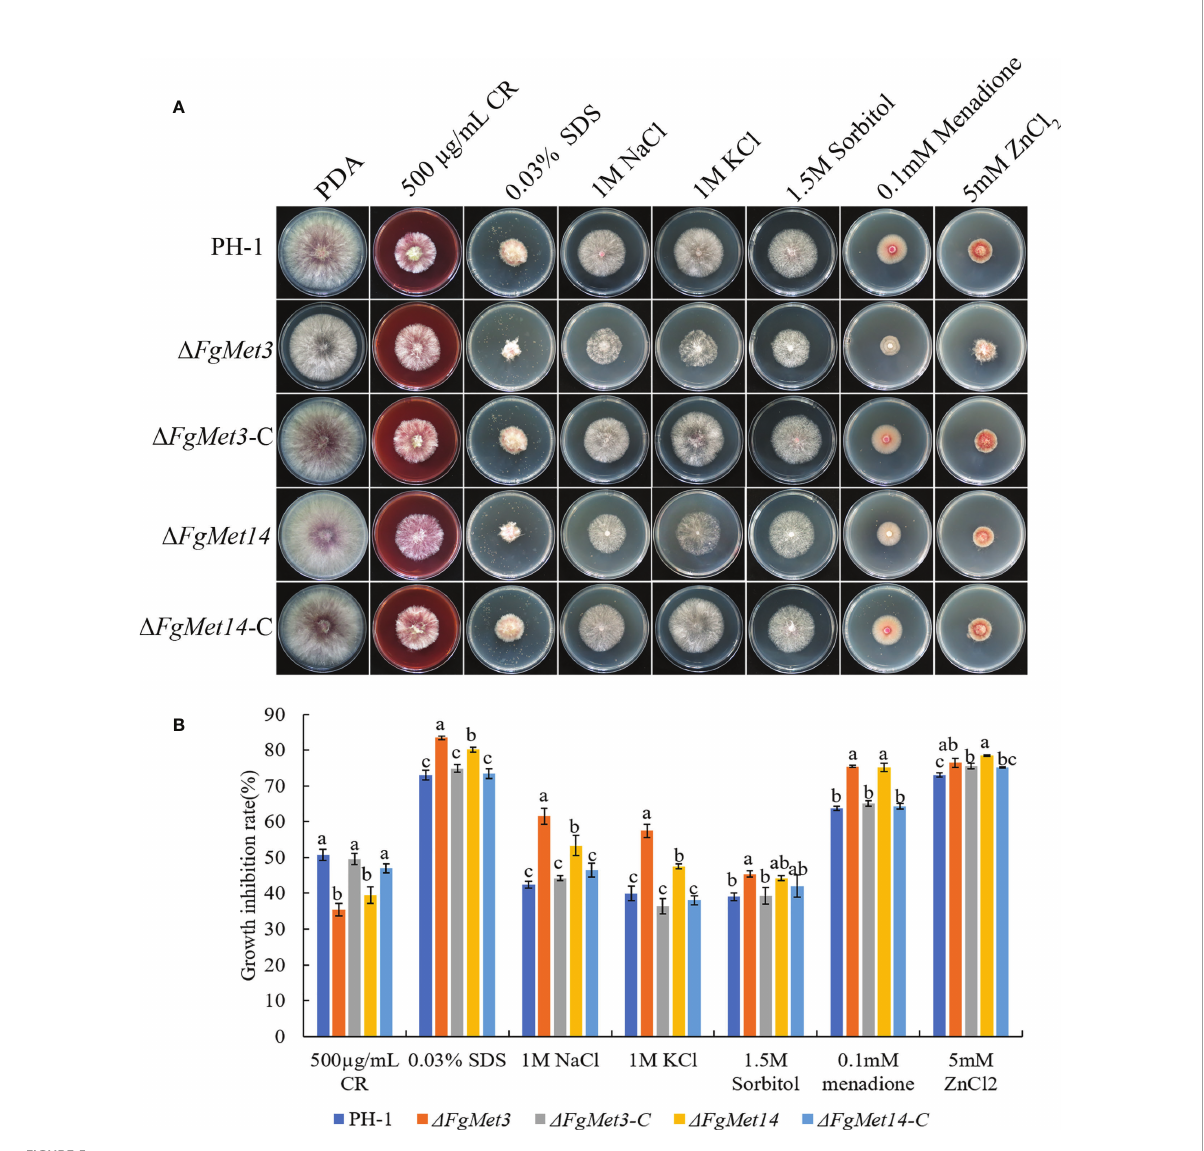
FIGURE 5 The sensitivity of D FgMet3 and D FgMet14 to different stress agents compared with PH-1 and complements. (A) The sensitivity of Fusarium graminearum wild-type PH-1, knockout mutants, and complementation strains to 500 µg/mL Congo red, 0.03% SDS, 1 M NaCl, 1 M KCl, 1.5 M Sorbitol, 5 mM ZnCl 2 , and 0.1 mM Menadione on PDA plate. (B) The inhibition of the mycelial growth rate was examined after each strain was incubated for 3 days on PDA supplemented with each stress compound. Bars denote standard deviations from three experiments. Within each treatment, bars with the same letter indicate no signi fi cant difference according to the least signi fi cant difference (LSD) test. P =